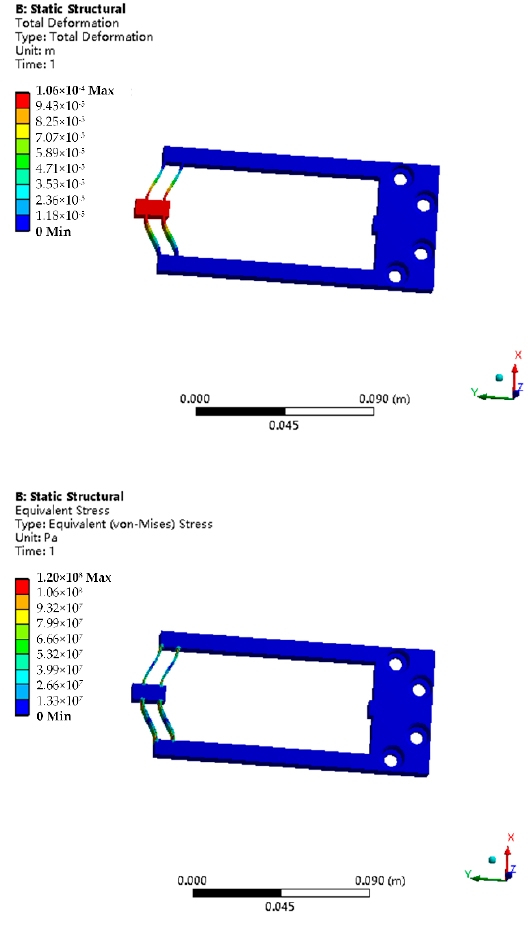
Figure 8. Maximum deformation and equivalent stress of the structure.